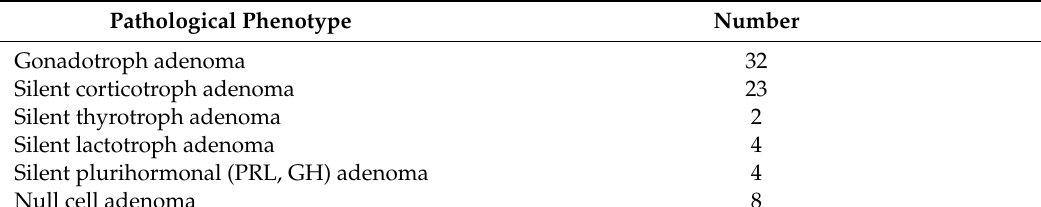
Table 1. Clinical, radiological, and histopathological characteristics of 73 patients with clinically nonfunctioning pituitary